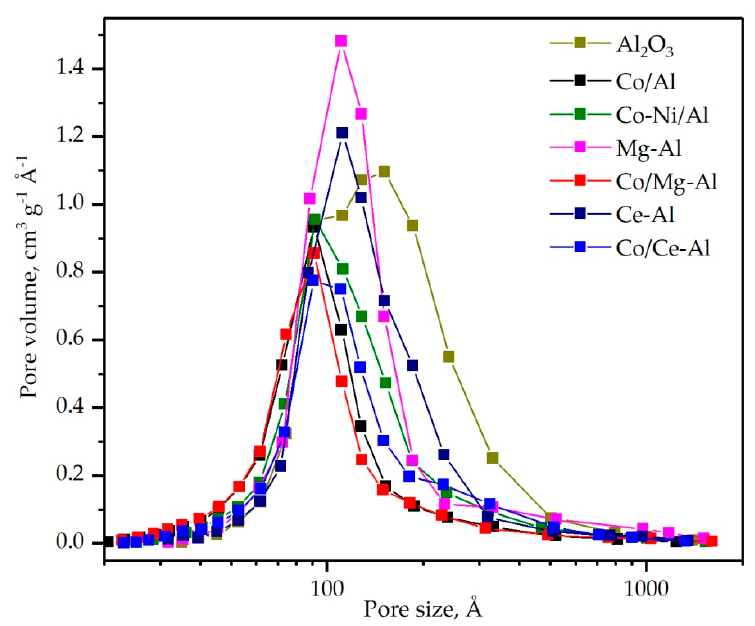
Figure 2. Pore size distributions of the supported cobalt catalysts.